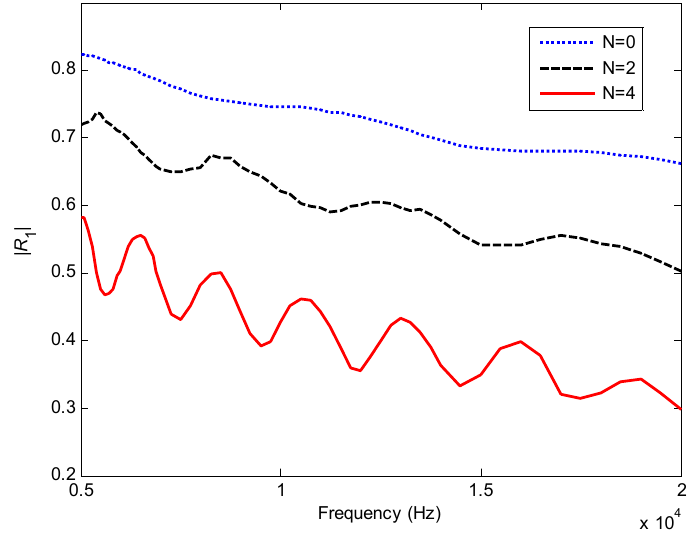
Figure 5. Reflection coefficients for FGP ends with different power law index N.